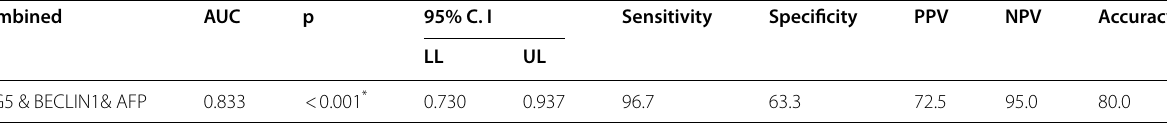
AUC: Area Under a Curve p value: Probability value